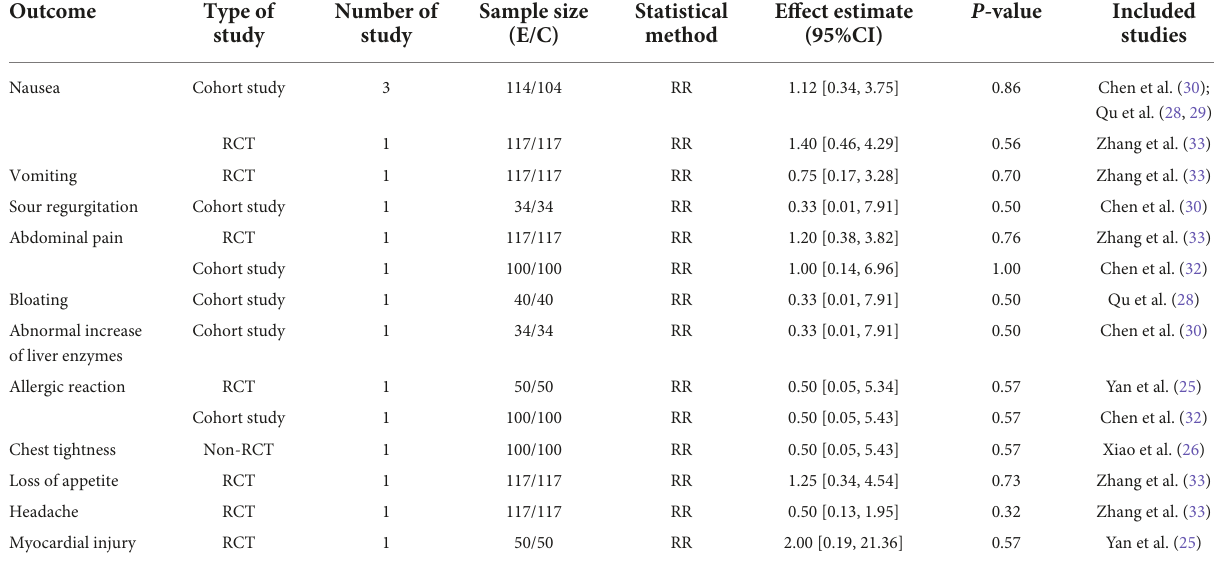
TABLE 5 Comparison of safety outcomes in the SFJD + WM group vs. the WM group in COVID-19 patients.